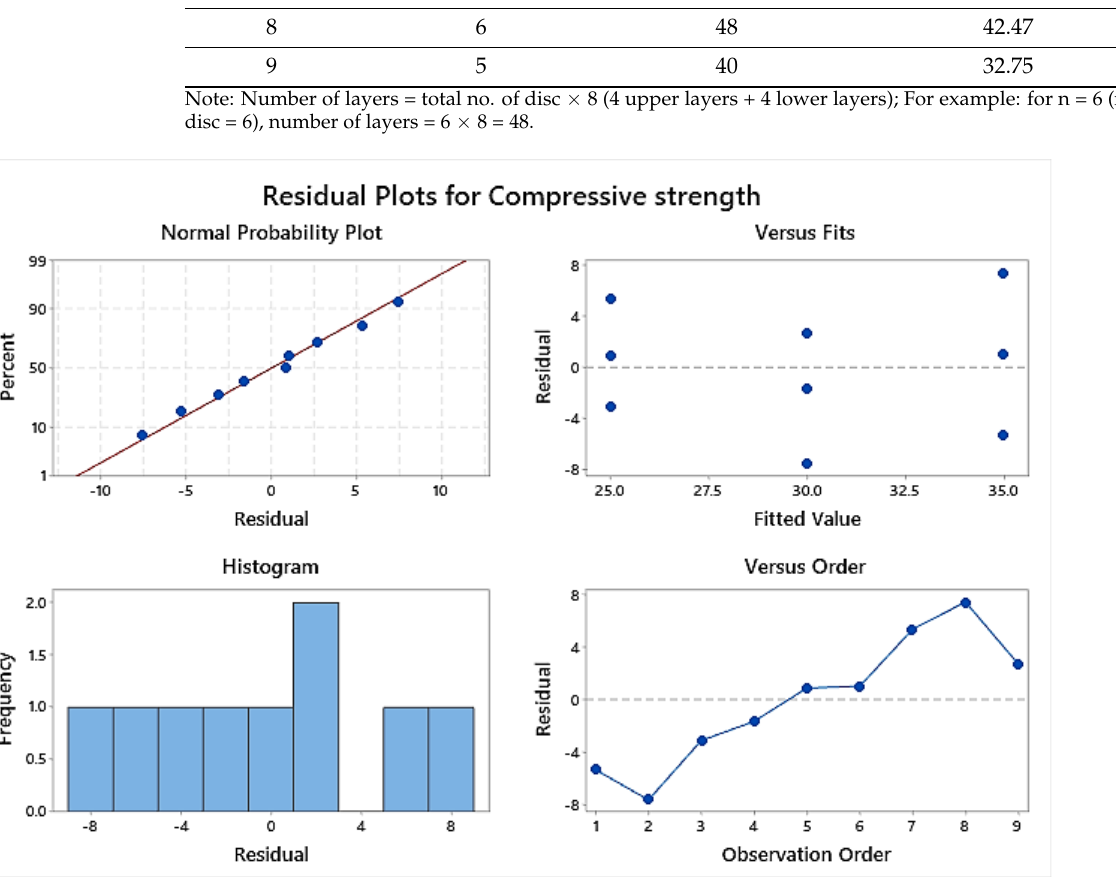
Figure 8. Correlation graph for the number of layers in the sample and compressive strength of the tested samples.